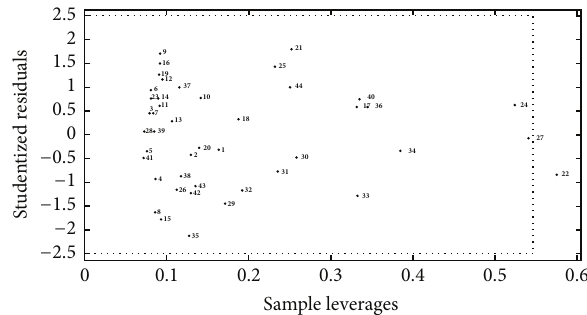
Figure 4: Plot of sample leverage versus Student residuals for the model Ali5 0.01 3.